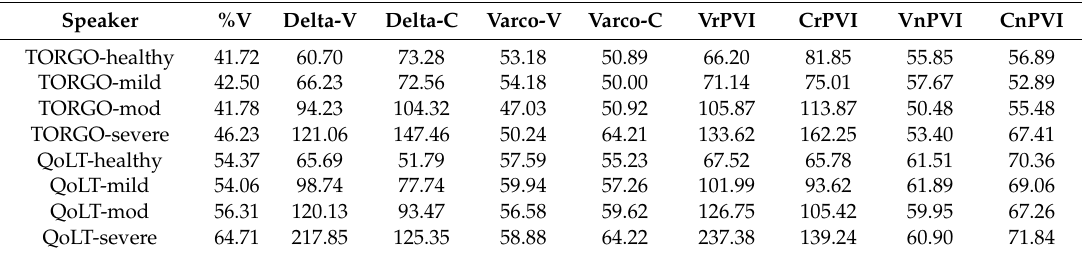
Table 4. Mean values for all rhythm metrics from TORGO and QoLT